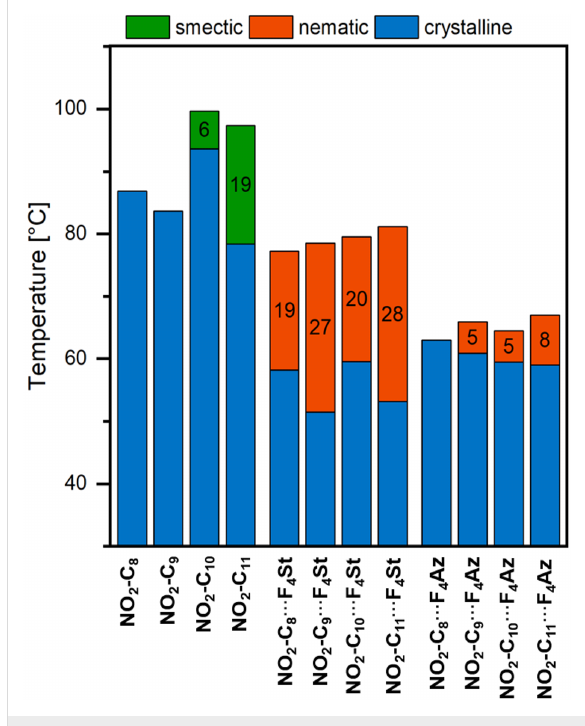
Figure 3: Comparison of the mesomorphic properties of NO 2 -C n , NO 2 -C n ∙∙∙ F 4 St , and NO 2 -C n ∙∙∙ F 4 Az ( n = 8–11). The transition tempera- tures were obtained by DSC upon cooling from the isotropic state. Mesophase ranges are given in black